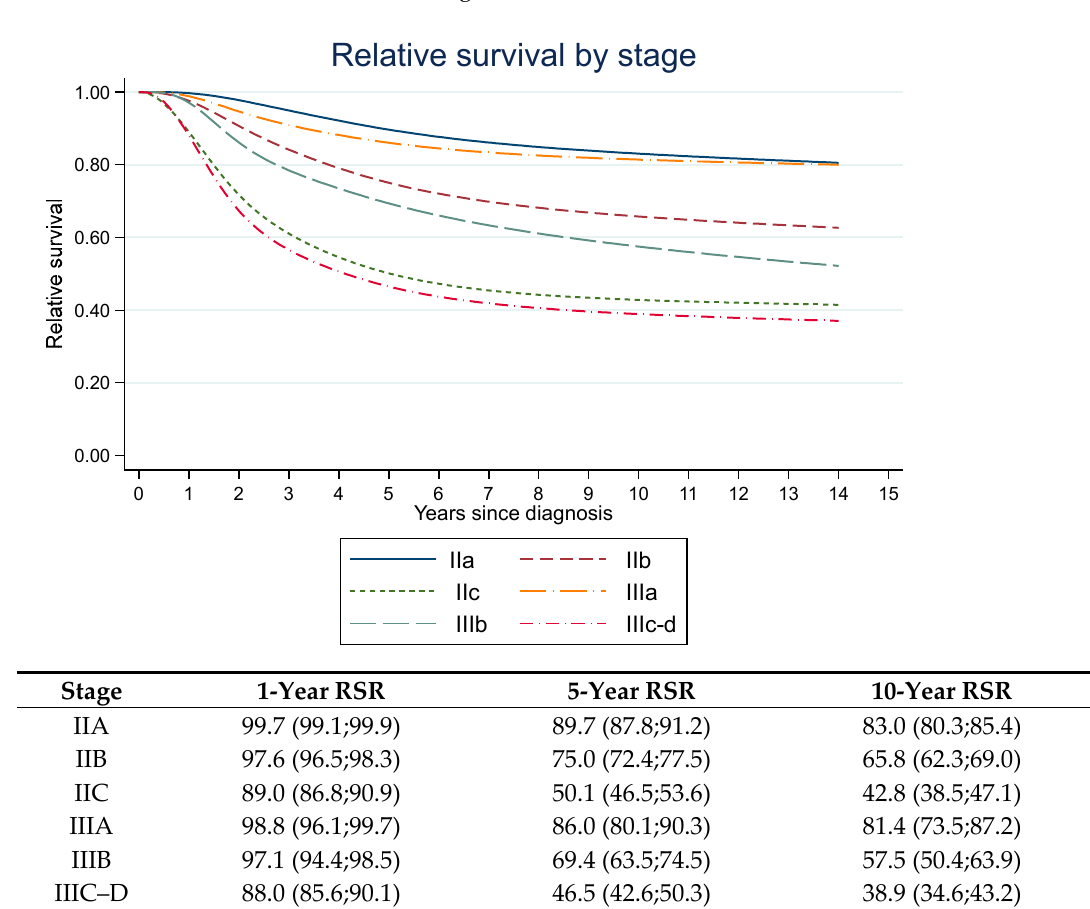
Crude (i.e., unadjusted) relative survival ratio (RSR) for stage II–III are presented in Figure 1. The cumulative unadjusted survival was similar for stages IIA and IIIA, IIB and IIIB as well as for stages IIC and IIIC–D.